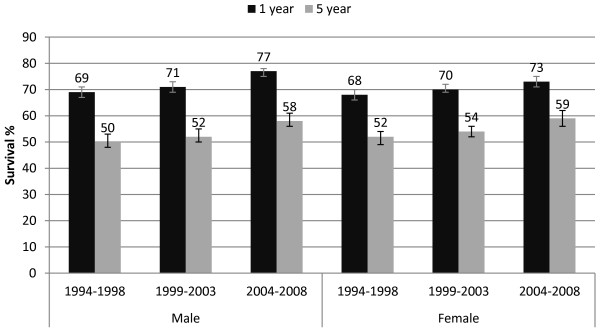
One and five year relative survival for colon cancer for diagnostic periods by sex with 95% confidence intervals.